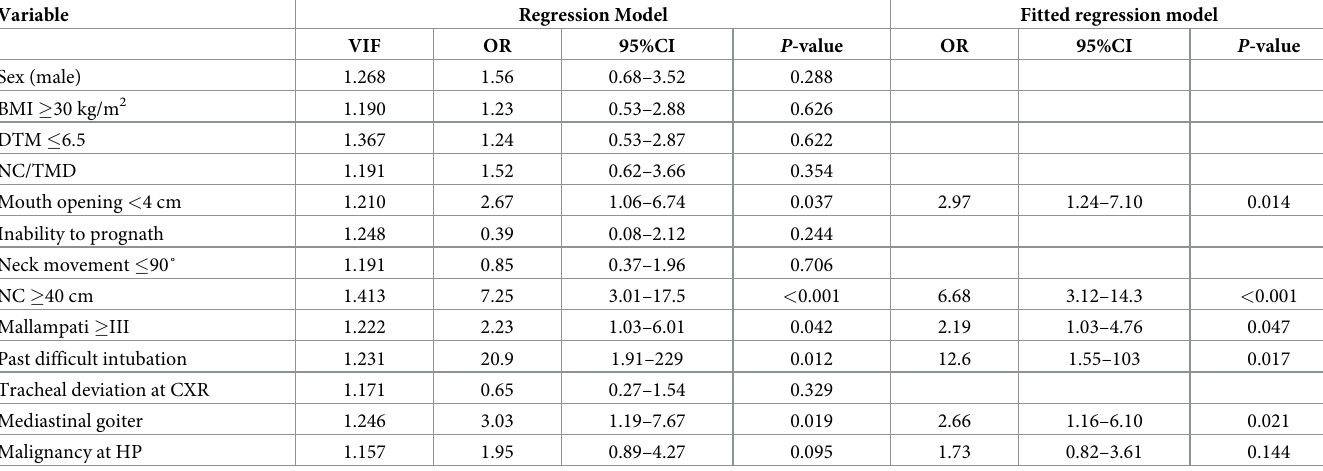
Table 2. Multiple linear regression analysis to explain the relationship between DTI and variables considered.